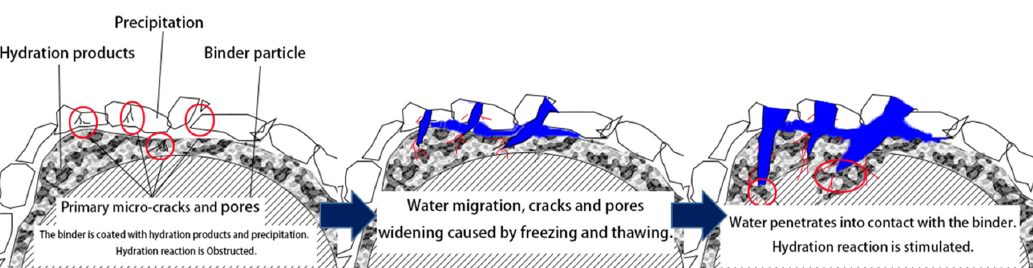
Figure 5. The UCS of Pb-CSCSs with the same contaminant content and different compound binders: ( a ) 0.05% Pb 2+ ; ( b ) 0.5% Pb 2+ , and ( c ) 1% Pb 2+ . Figure 4. Schematic diagram: Activation of hydration by freeze-thaw Figure 4. Schematic diagram: activation of hydration by freeze-thaw cycles.